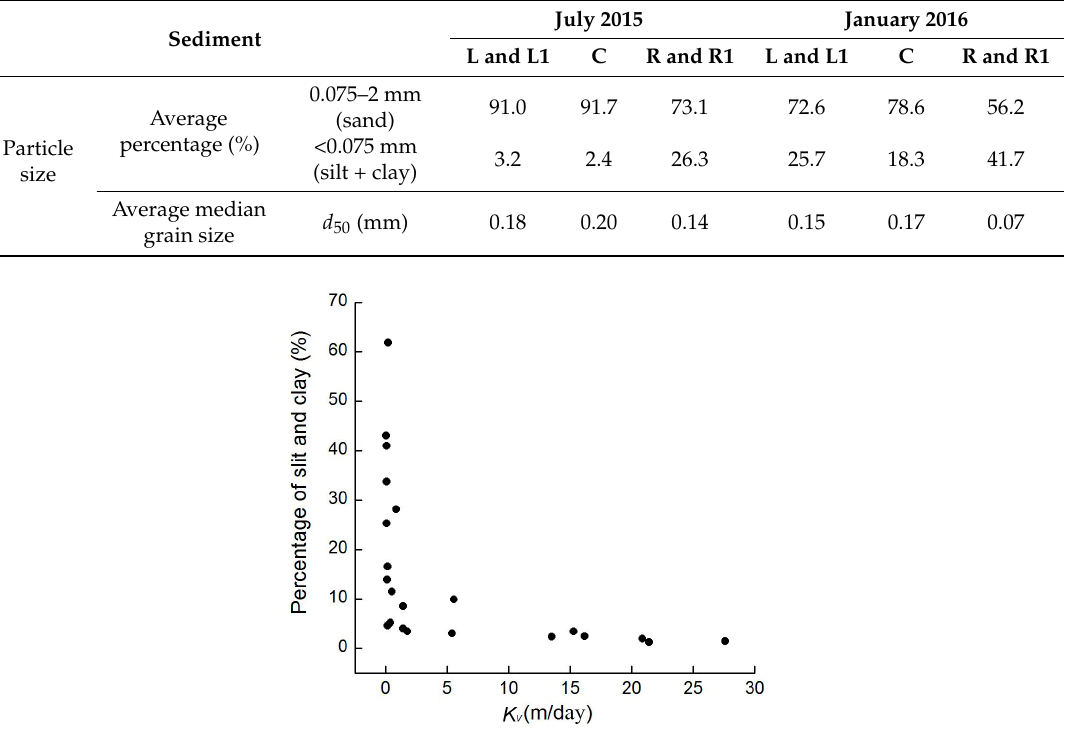
Figure 7. Relationship of K v and the percentage of silt and clay.